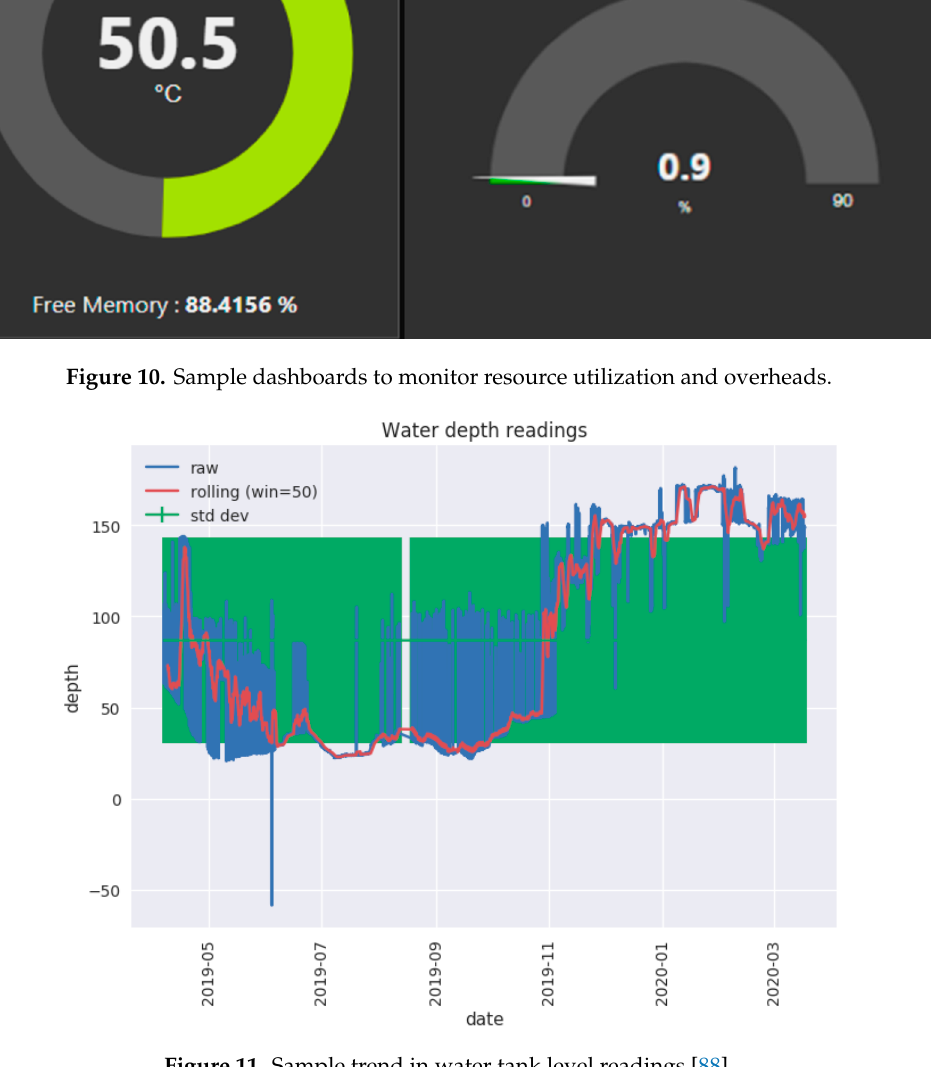
Figure 11. Sample trend in water tank level readings [88].